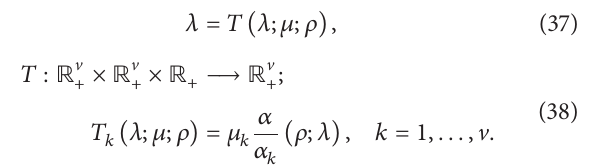
A graphical representation of (36) in V = 2 and V =